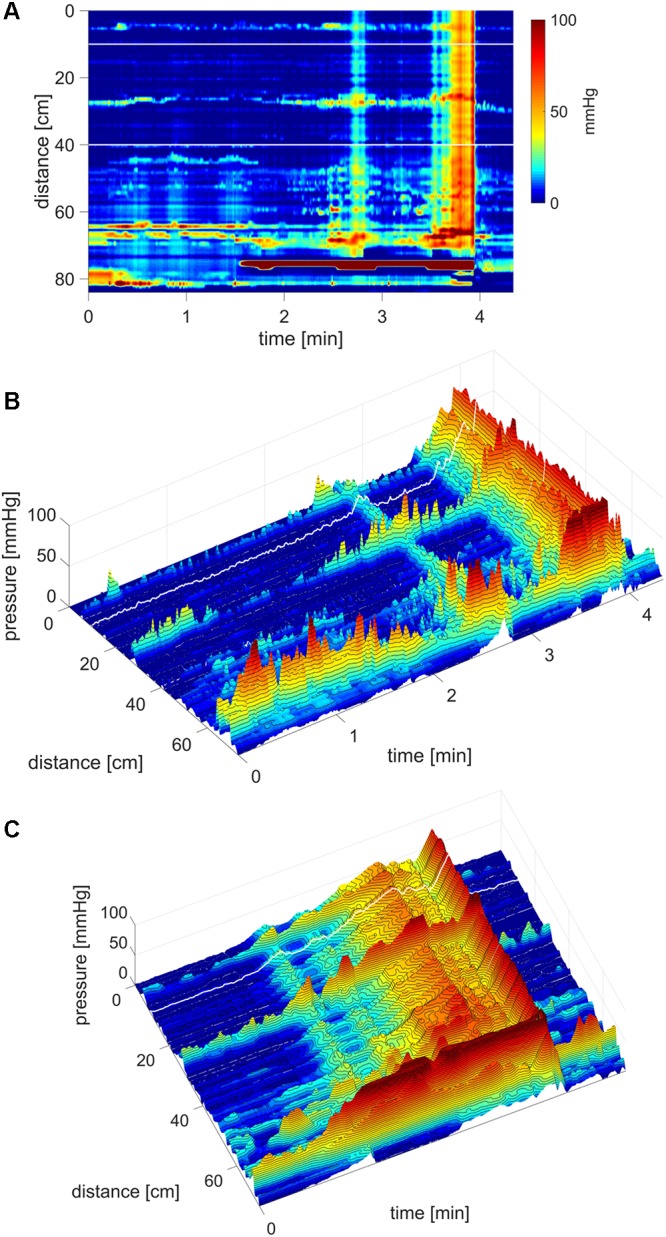
A high amplitude SPW associated with balloon expulsion. (A) Two SPWs appear in response to rectal balloon distention; the dark area above the anal sphincter shows the pressure in the rectum induced by the balloon. The first SPW was associated with liquid outflow. The second SPW consists of a cluster of high frequency multiple pressure waves, the last wave at 55 mmHg is followed by relaxation of the sphincter and it expels the balloon. Preceding the balloon expulsion, the SPW was associated with pain and urge. (B) 3D image of (C), the balloon distention and anal sphincter activity was removed to make the SPW better visible. (C) Close up of the second SPW as shown in (B) where its composition of multiple pressure waves is clearly visible.